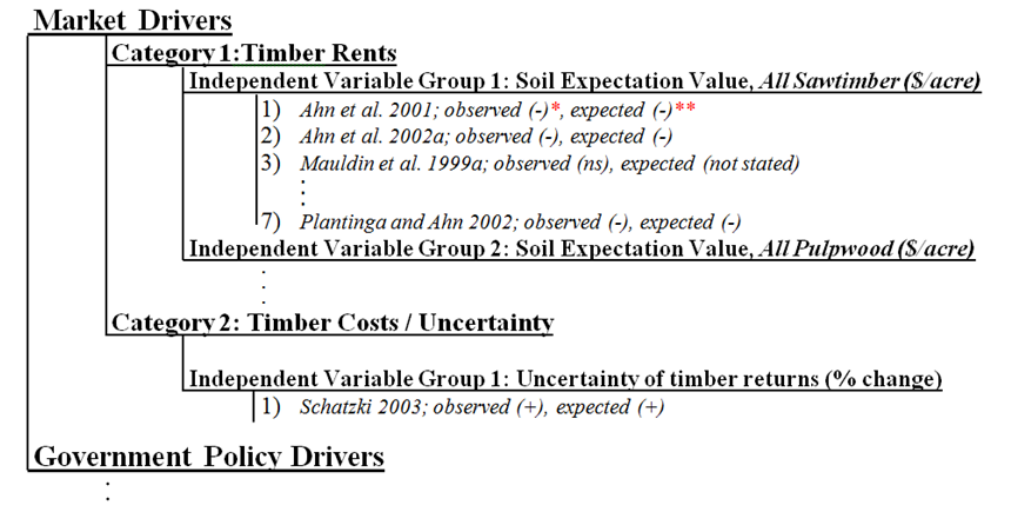
Figure 1. Example of groupings of the F2A models used for vote count meta-analysis of econometric independent variables predicting forestland